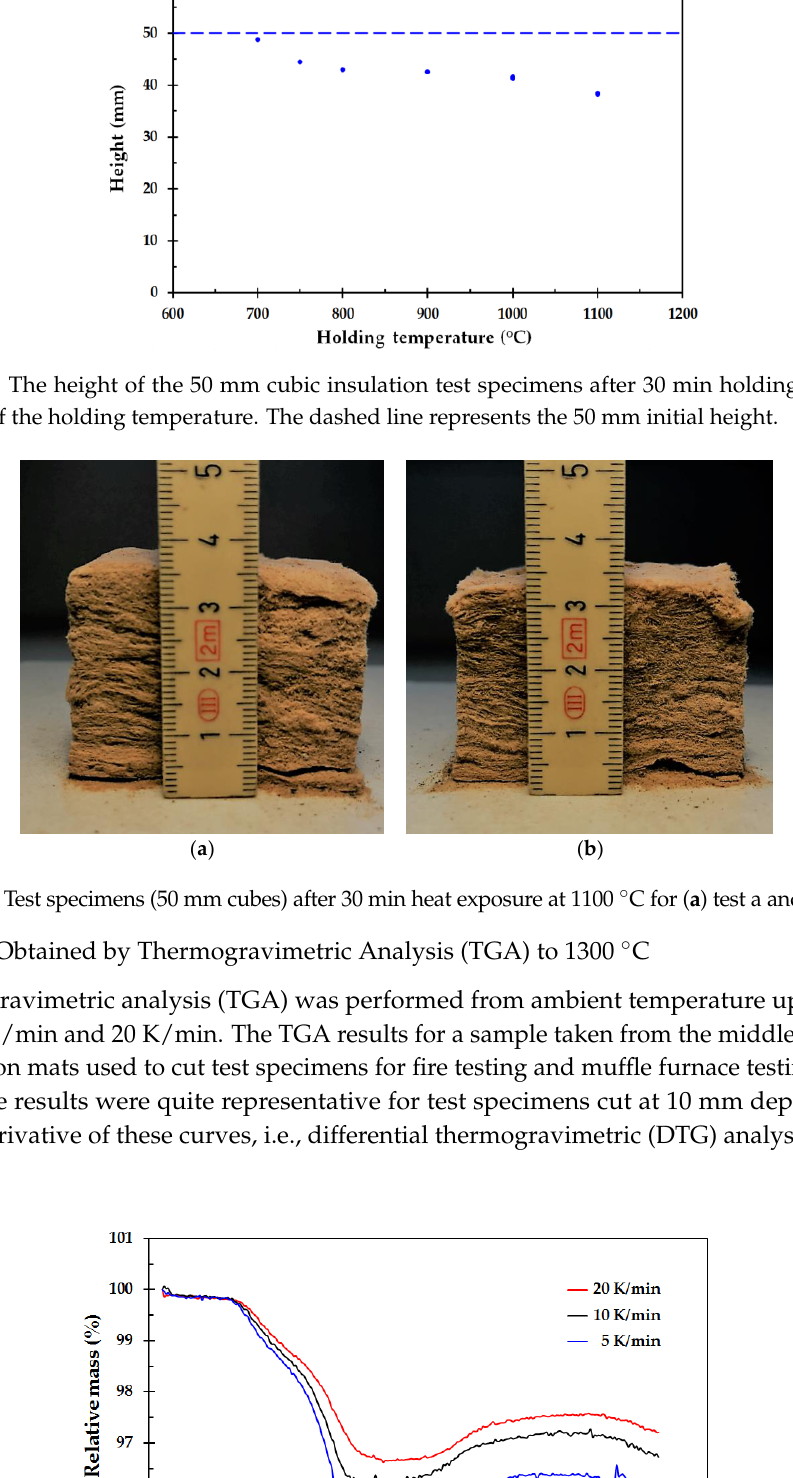
Figure 15. Differential thermogravimetric (DTG) analysis of the results shown in Figure 14. As seen in Figure 15, the mass loss starts at about 200 °C, with a local minimum in the temperature range 240 °C to 260 °C. This is most likely due to the dust binder mineral oil decomposition/evaporation. The next minimum, with maximum mass loss rates in the range 450 °C to 480 °C, may be a result of Bakelite decomposition. When mixed with other chemicals, the Bakelite may decompose at different temperatures than pure Bakelite, as experienced by Solyman, et al. [10]. The second minimum is therefore most likely due to decomposition of the Bakelite binder, or parts of the Bakelite binder. From about 700 °C, there seems to be a mass gain, peaking at about 760 °C to 770 °C. The current study has no explanation of this observation. From about 860 °C, there is only some mi nor mass loss throughout for the remaining heating to 1300 °C. For some of the tests, the gas emissions were analyzed by fourier transformed infrared spectroscopy (FTIR). The FTIR recordings revealed traces of H 2 O, CO 2 and CO during the entire heating period, though the concentration of these gas species were most profound at the start of the heating process and at the end of the heating process. The higher production of these species early in the heating process is probably due to dust binder and Bakelite decomposition. The higher concentration at the end of the heating process may indicate some chemical reactions related to the minerals comprising the thermal insulation fibers, including traces of other minerals than presented in Appendix A, Table A3.